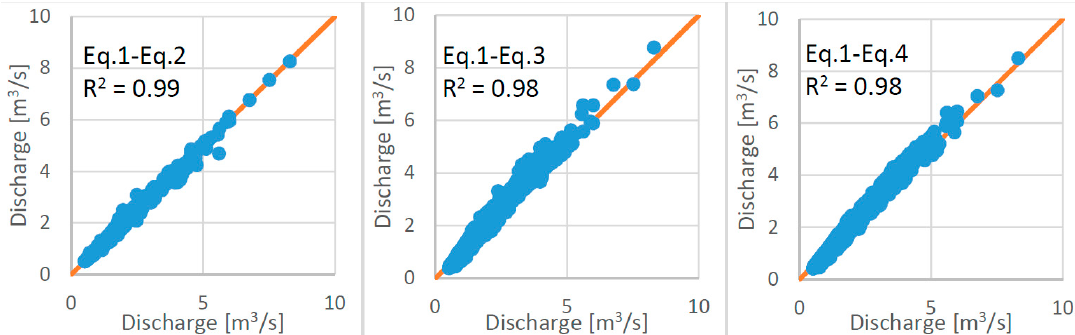
Figure 5. Comparison among the CemaNeige GR6J results for the Kranjska Gora station on the Sava Dolinka river using different input values for the mean air temperature estimates. X-axis in all three cases show results obtained using Equation (1) while the y-axis show results using Equation (2), Equation (3), and Equation (4) (from left to right).